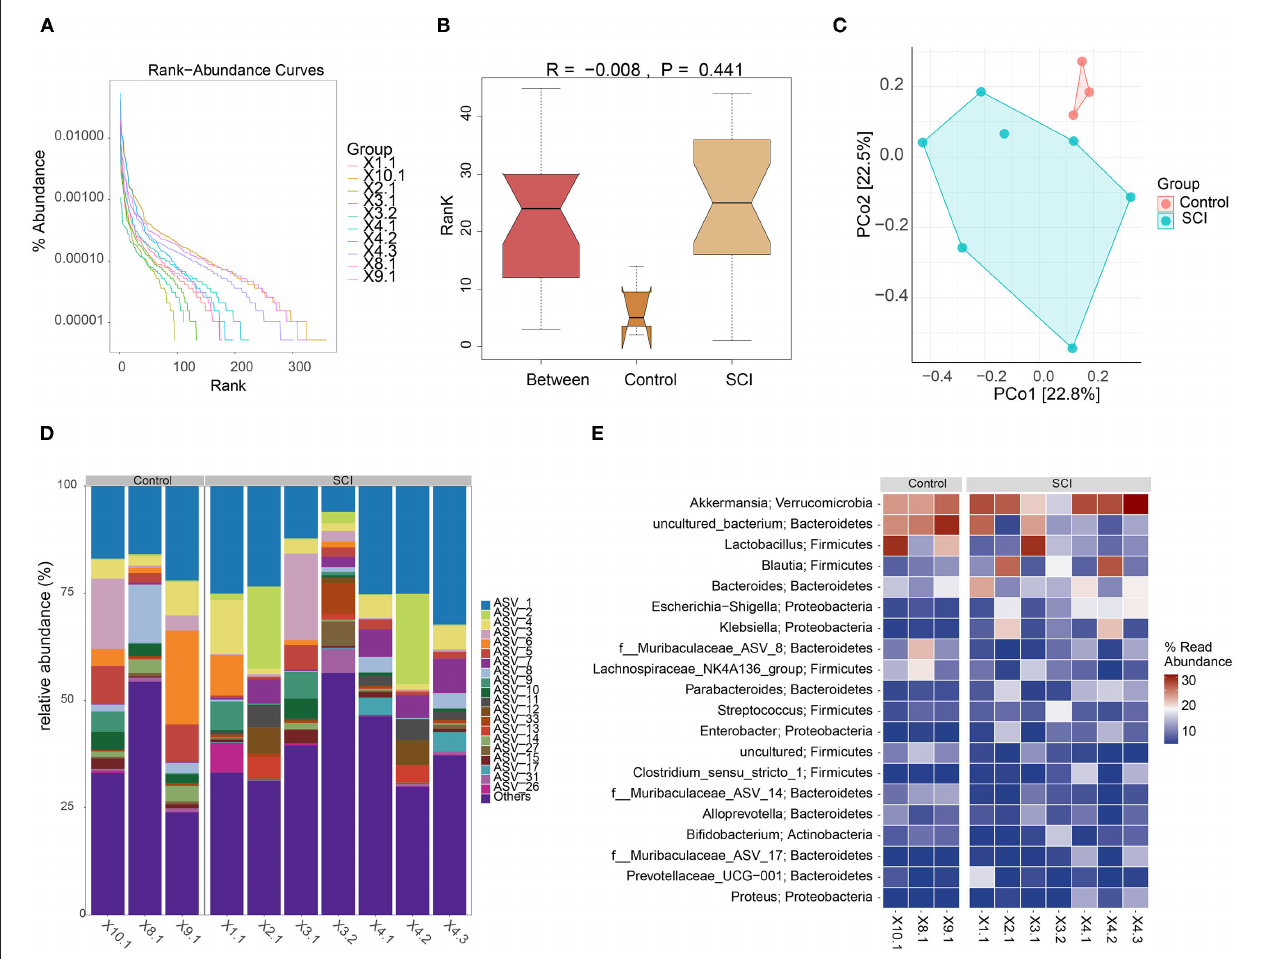
FIGURE 5 | Gut microbiota analyses. (A) Rank-abundance curve. (B) Box plot of diversity differences between the analyses of similarities groups. (C) Principal component analysis plot. (D) Histogram of species distribution. (E) Operational taxonomic unit abundance clustering heat